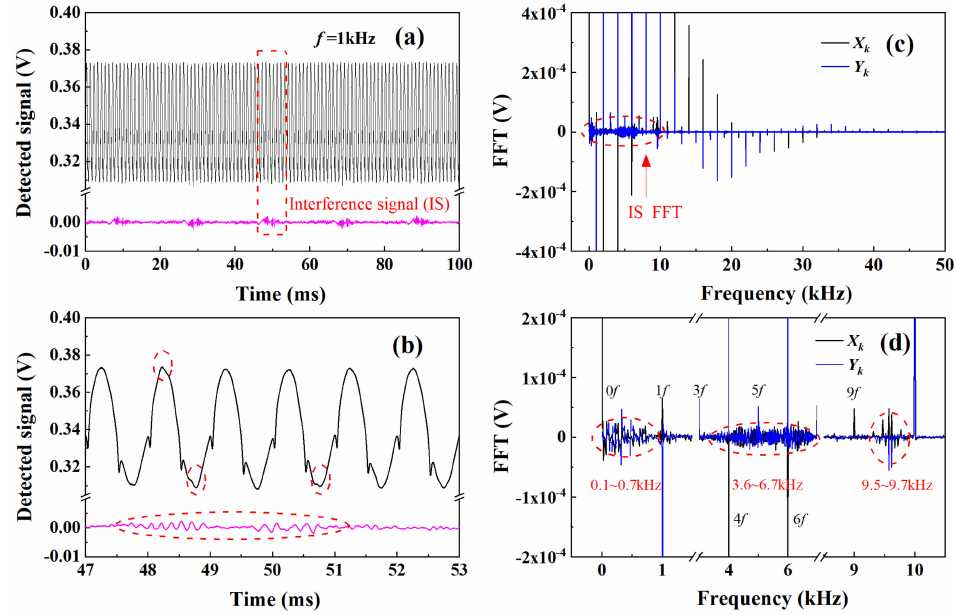
Figure 3. ( a , b ) detected transmitted light intensity with noise, ( c , d ) its Fourier coe ffi cients. The experimental condition is similar with that in Part I: CO / N 2 mixture gas, T = 299 K, L = 14.7 cm, Xco = 1.02%, P = 101.3 kPa